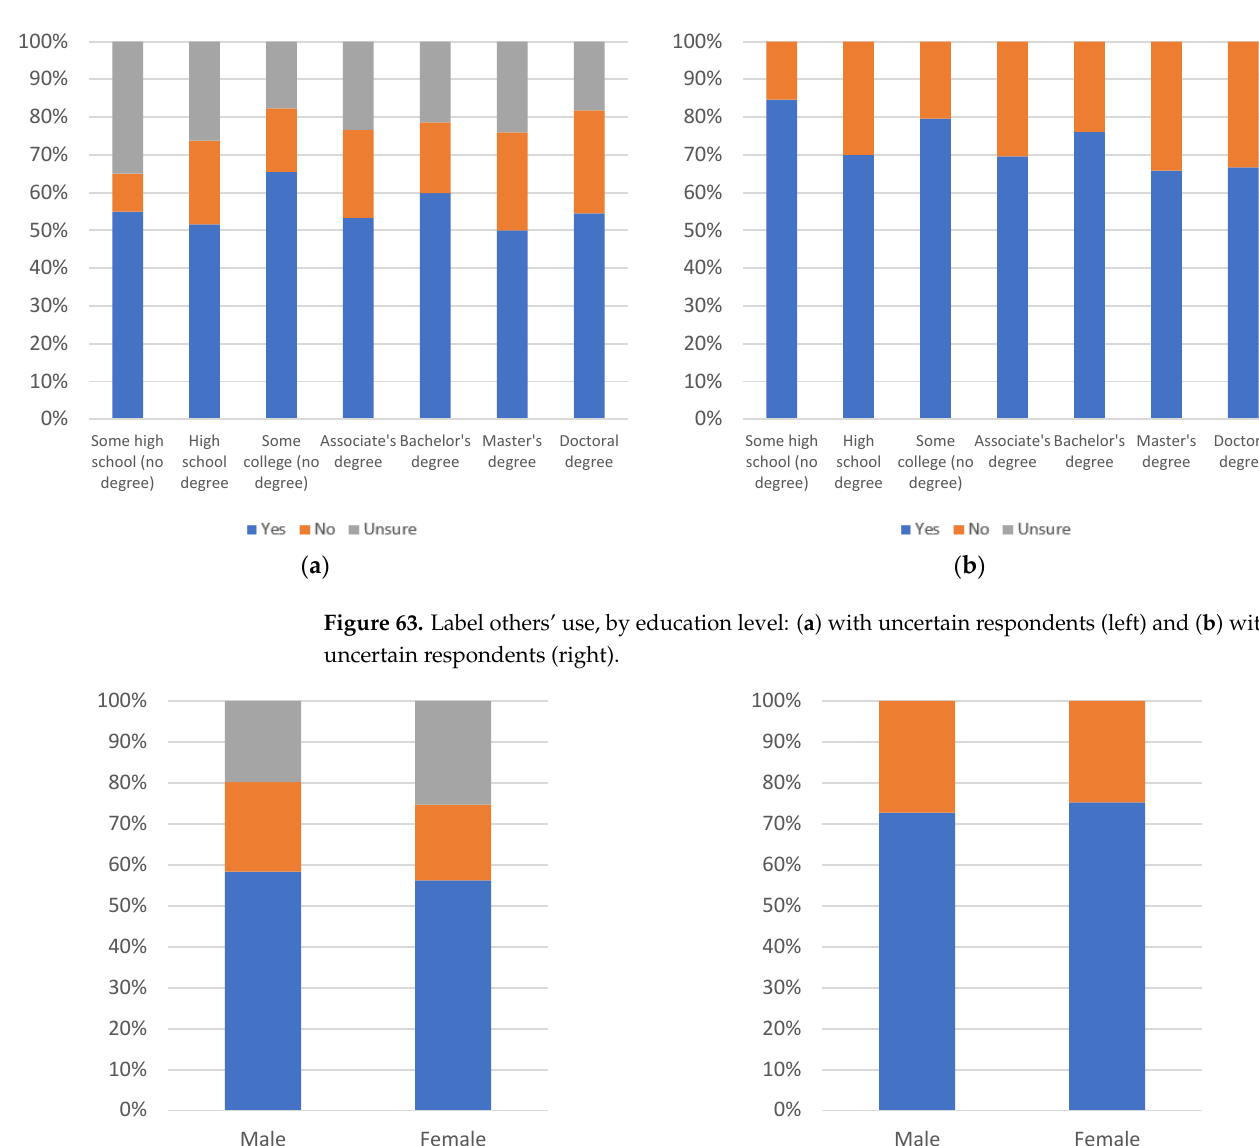
Figure 62. Label others’ use, by age group: ( a ) with uncertain respondents (left) and ( b ) without uncertain respondents (right).